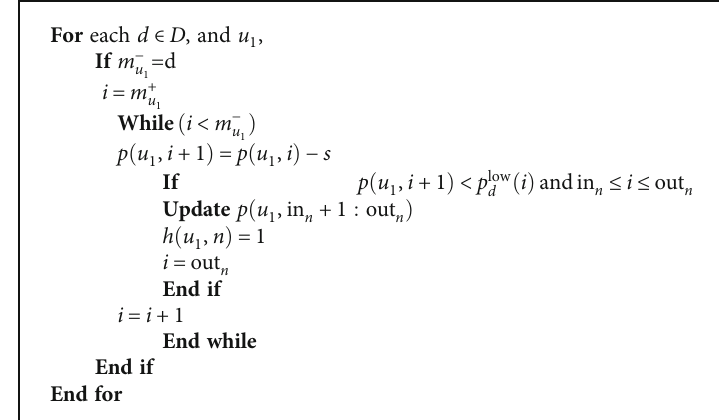
Algorithm 2: Calculate p